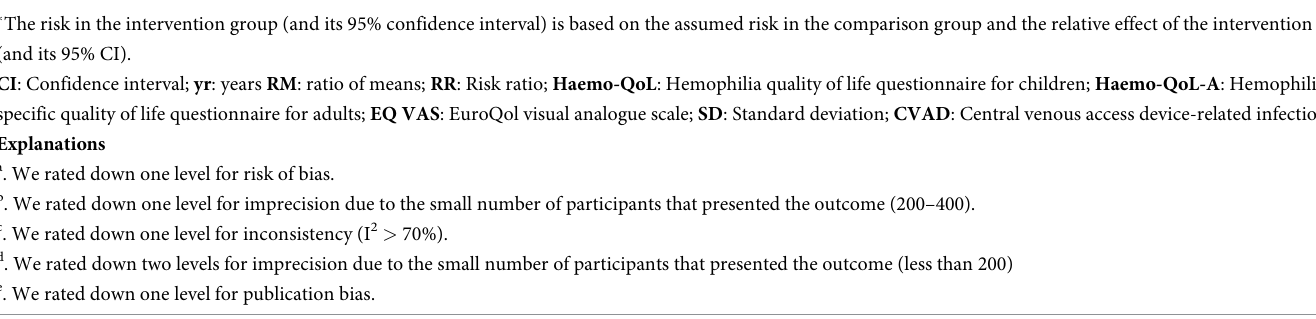
certainty of evidence (Table